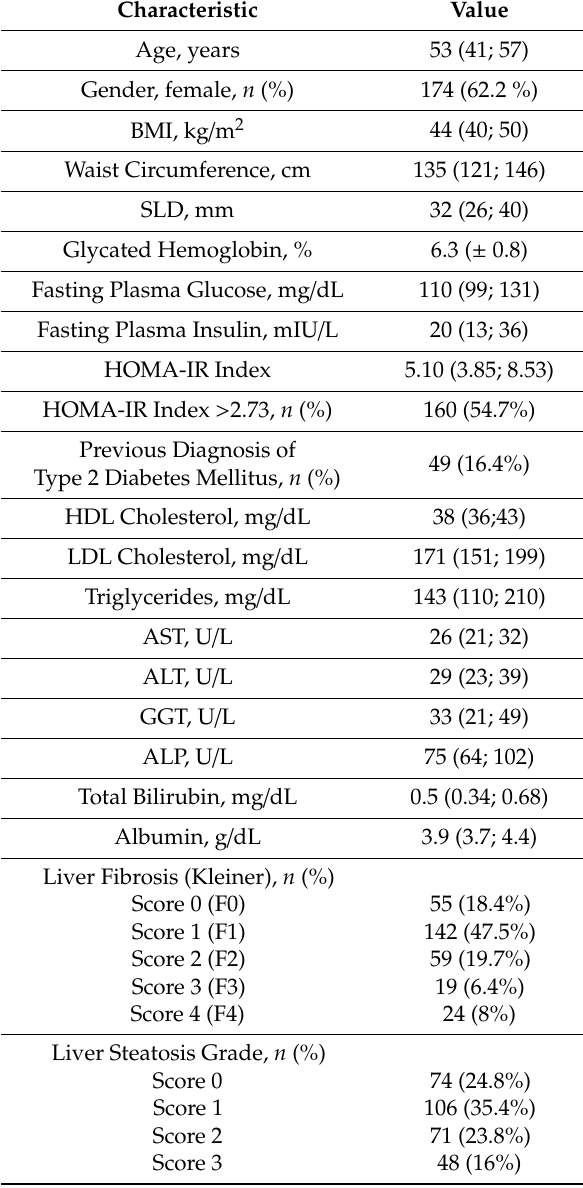
Table 1. Patients’ clinical, biochemical and histological characteristics. Continuous variables are reported as median (Quartile1; Quartile3) or mean ( ± SD). Discrete variables are reported as the number and proportion of subjects with the characteristic of interest. Abbreviations: BMI = body mass index; SLD = Skin-to-Liver Distance; HDL = high-density lipoprotein; LDL = low-density lipoprotein; AST = aspartate aminotransferase; ALT = alanine aminotransferase; GGT = gamma-glutamyl-transferase; ALP = alkaline